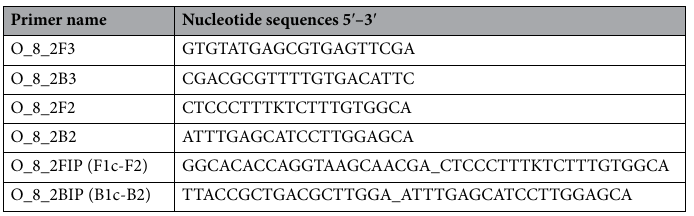
Table 1. Primer sequences used in the LAMP assay.